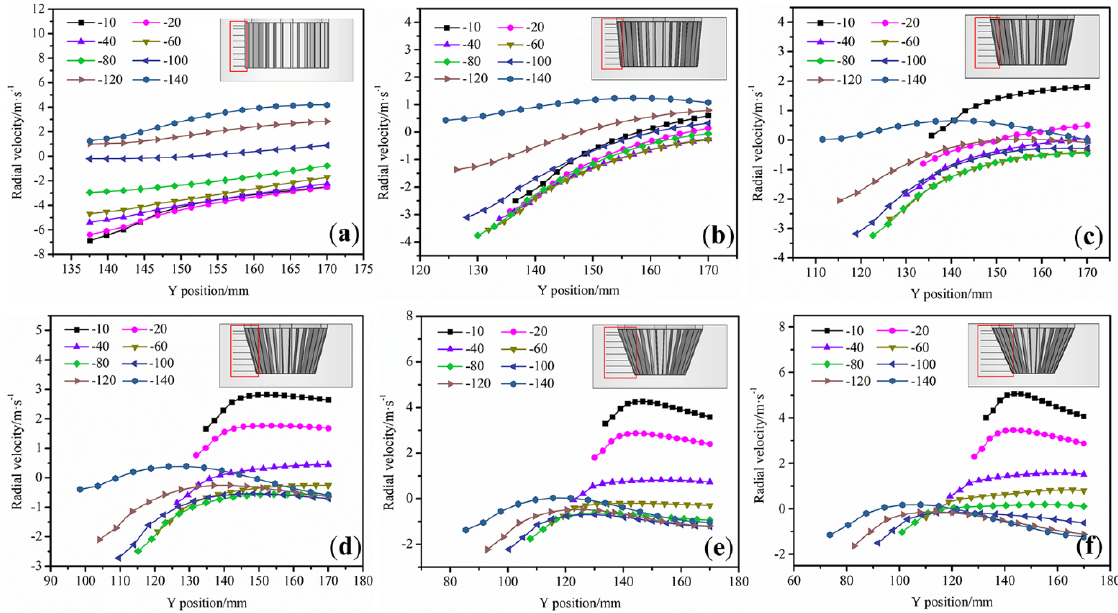
Figure 7. Radial velocity distribution at different heights in the classifying chamber: ( a ) T-A (1-1) , ( b ) T-B (1-0.9) , ( c ) T-C (1-0.8) , ( d ) T-D (1-0.7) , ( e ) T-E (1-0.6) , and ( f ) T-F (1-0.5).